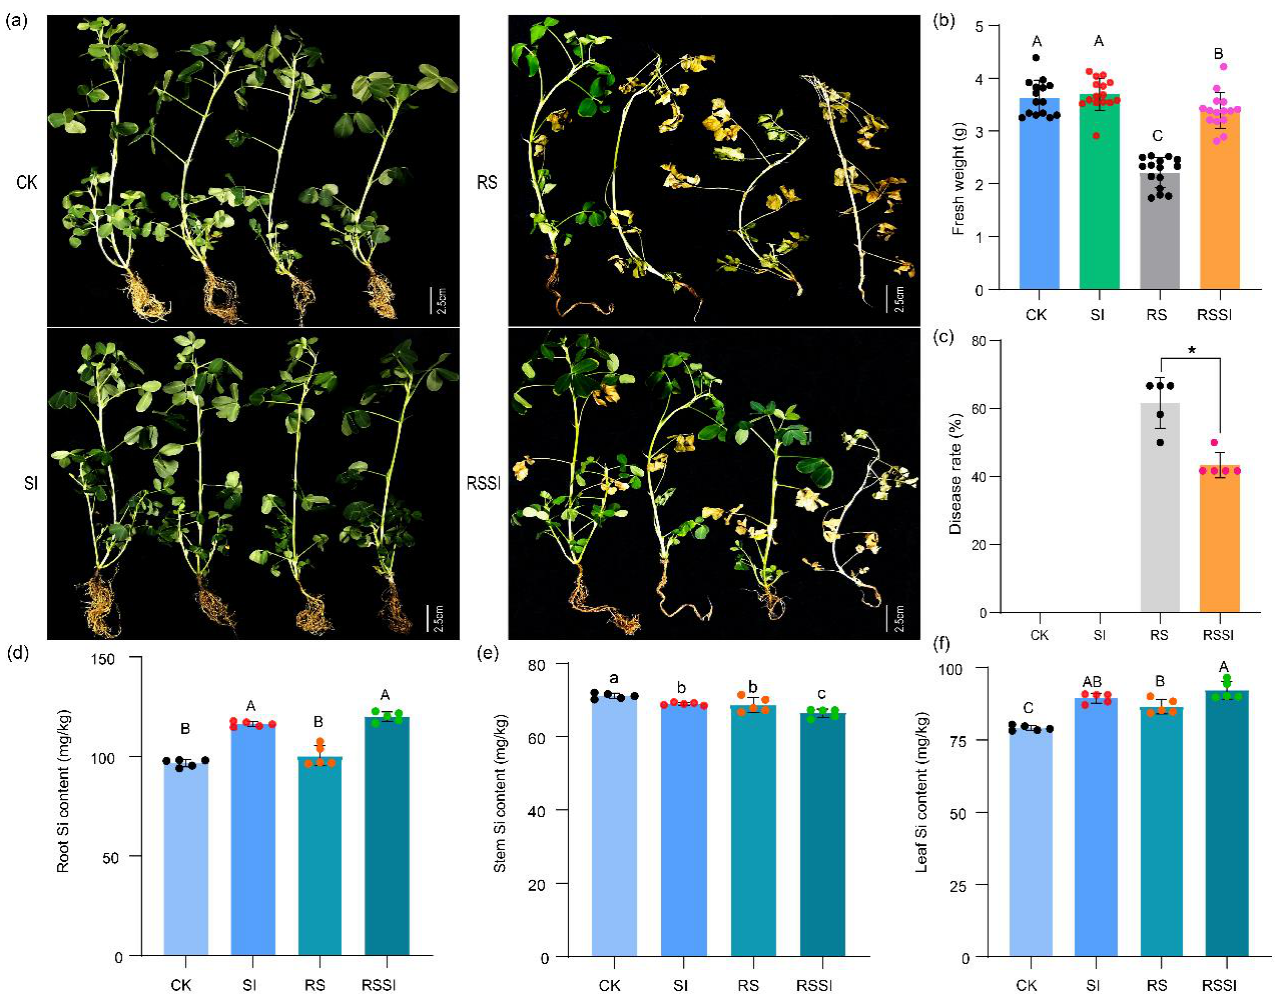
Figure 1. Fresh weight, disease rate, and Si contents of peanut plants at the 30th day after R. solanacearum inoculation. ( a ) Variation in the growth overview of peanut plants under CK, SI, RS, and RSSI treatments. ( b ) Fresh weight of peanut plants under CK, SI, RS, and RSSI treatments (capital letters indicate p < 0.01). ( c ) Disease rate of peanut plants under distinct treatments at the 30th day after inoculation (*, p < 0.05). ( d – f ) Si contents of the root, stem, and leaf of peanut plants under CK, SI, RS, and RSSI treatments (capitals and small letters indicate p < 0.01 and p < 0.05, respectively).